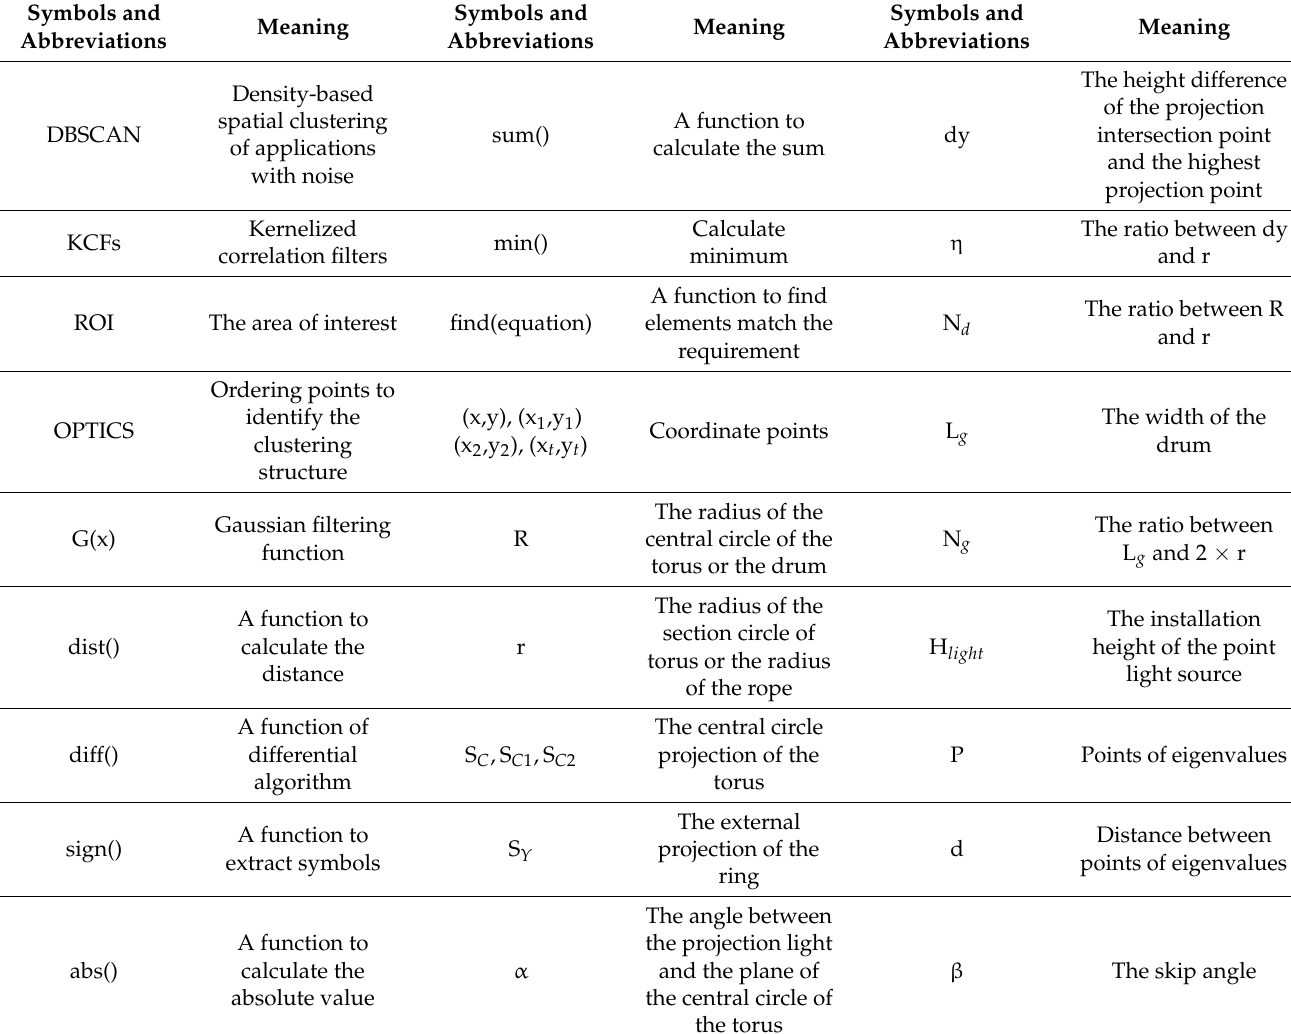
The meanings of abbreviations and symbols used in this paper are shown in Table 2. Table 2. Symbols and abbreviations used in this